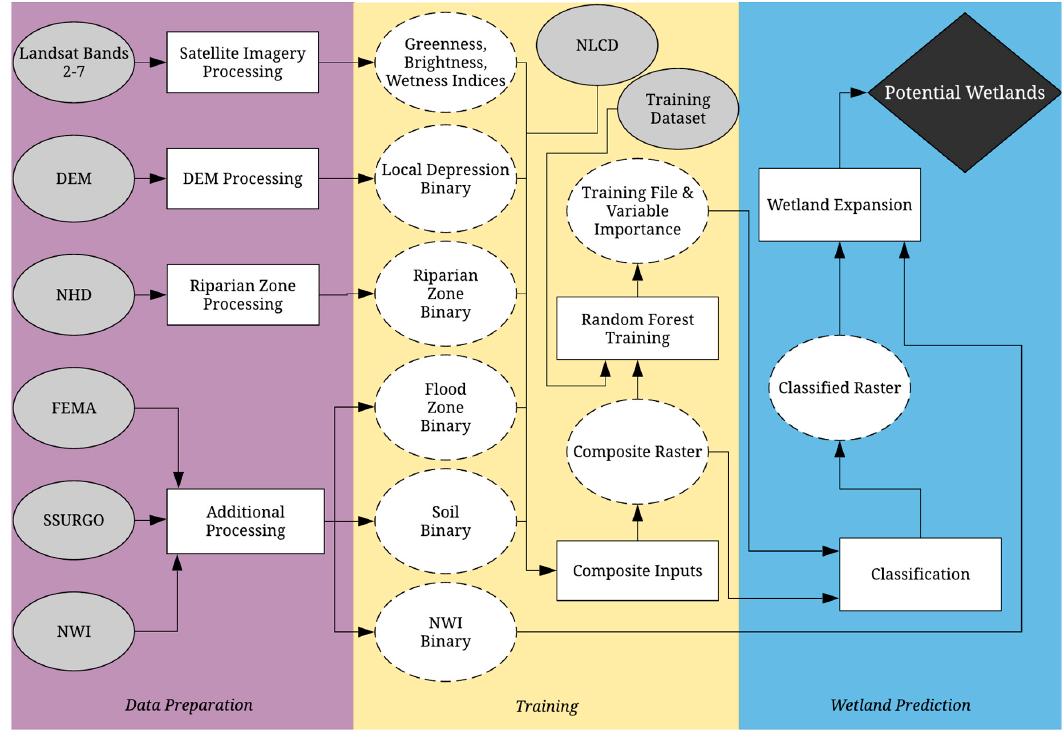
Figure 3. Wetland screening workflow which is implemented in ArcGIS 10.4 and consists of three main sections: data preparation, training, and wetland prediction. Input data to this workflow have been preprocessed, as described in the text, and have a common pixel resolution (3 m), processing extent, and projected coordinate system (North American Datum 1983 Virginia South State Plane). “DEM” = digital elevation model; “NHD” = National Hydrography Dataset; “FEMA” = Federal Emergency Management Agency; “SSURGO” = Soil Survey Geographic Database; “NWI” = National Wetland Inventory; “NLCD” = National Land Cover Database.